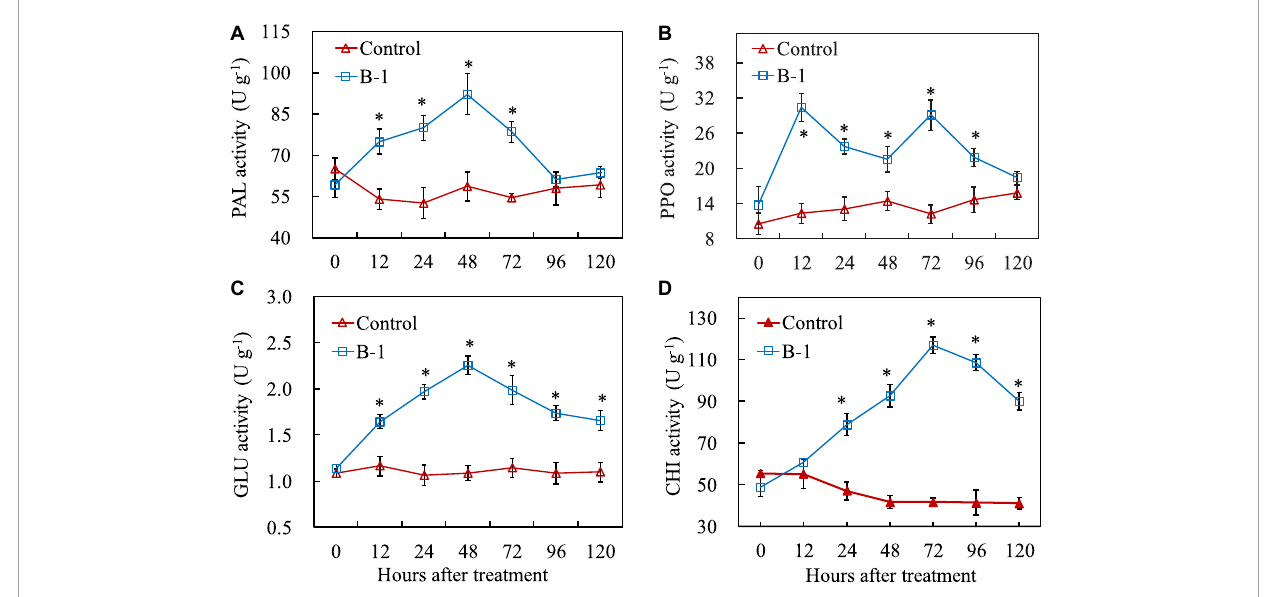
FIGURE6 The activities of PAL (A) , PPO (B) , GLU (C) , and CHI (D) in apple fruit treated with P. syringae B-1 at 1 × 10 8 CFU mL– 1 stored at 25 ◦ C. Each data represents the mean ± SD of three replicates. Asterisks ( ∗ ) denote a significant difference ( p < 0.05) between the strain B-1 treatment and the control apple fruit at the same time